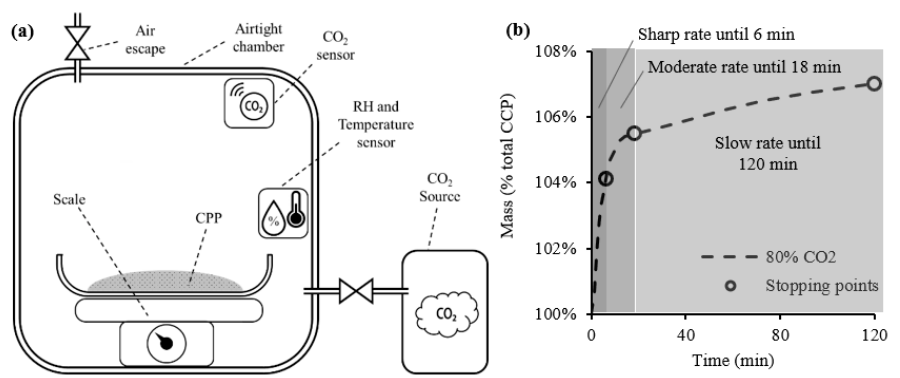
Figure 2. Equipment setup for the mass growth analysis ( a ) and stopping points for further CPP testing ( b ).